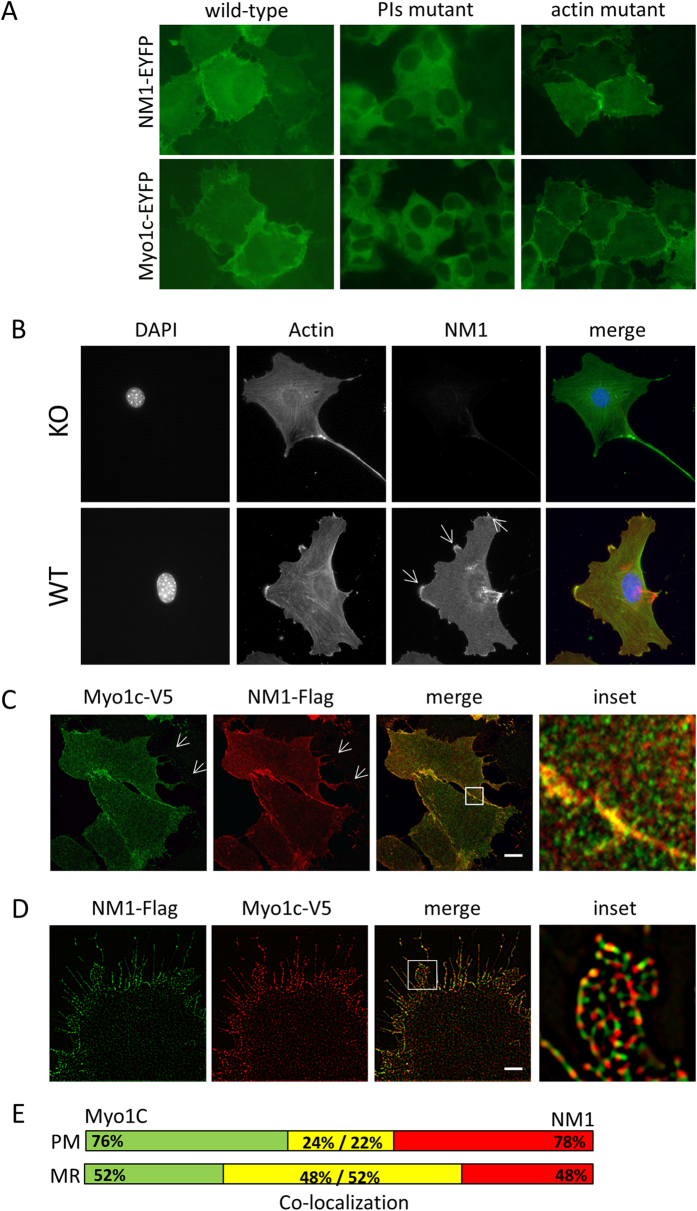
NM1 and Myo1c are enriched at the plasma membrane.(A) Wild-type NM1-EYFP or Myo1c-EYFP and their respective mutants (actin-binding or PI-binding) were stably expressed in U2OS cells, and their localization was observed by wide-field fluorescence microscopy. Plasma membrane association is disrupted upon mutation of the PI-binding site of myosins. (B) NM1 wild type and KO skin fibroblasts were fixed and immunostained with NM1 and actin antibodies. NM1 is co-localizing with actin in focal adhesions and membrane ruffles. Deletion of NM1 does not cause any alteration in actin cytoskeleton structure. (C) NM1-Flag and Myo1c-V5 were co-expressed in the U2OS cells and detected by confocal fluorescence microscopy. Both proteins co-localize at the plasma membrane and in membrane ruffles (arrows). (D) Localization of NM1-Flag and Myo1c-V5 was inspected by SIM. Both proteins are localized at the plasma membrane in a mosaic pattern and do not overlap entirely. (E) Visualisation of co-localization measurement of Myo1C and NM1 from inset pictures in 3C and 3D. PM – plasma membrane, MR – membrane ruffles. Scale bars, 5 μm (C) and 2 μm (D).